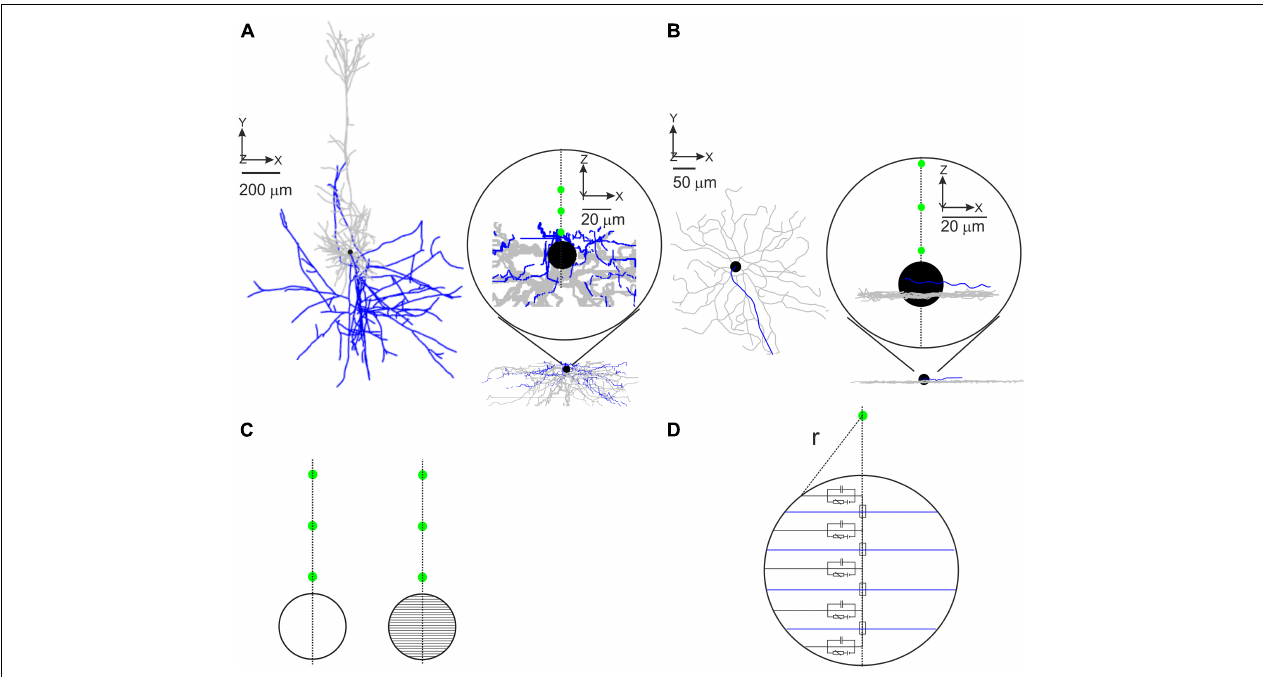
FIGURE 1 | Implementation of realistic model neurons. Representative PC (A) and RGC (B) model geometries. Only the first three investigated electrode positions (15, 30, and 45 µ m) are shown as green circles in the insets. Dendrites shown in gray, axon in blue, and soma in black. (C) The soma was modeled as a single compartment (left) or was split into 41 compartments (right). The main axis of the multi-compartment soma was oriented toward the electrode. The green circles represent the first three investigated electrode positions. (D) Scheme of the segmented soma (only five compartments for better visibility) with the Euclidian distance ( r ) to the electrode (green) used to calculate the extracellular potential.